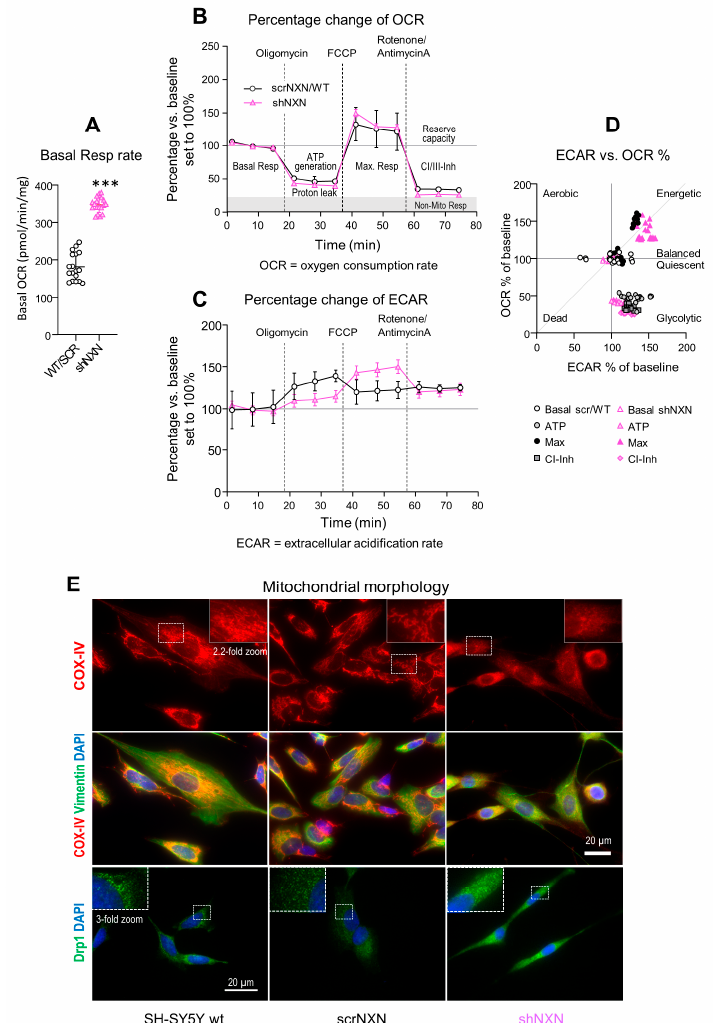
Figure 3. Seahorse analysis of oxidative respiration and extracellular acidification. ( A ) Mitochondrial respiration was analyzed on the Seahorse analyzer. The oxygen consumption rate (OCR) shows the absolute basal respiration (every 3 time points per culture) in shNXN and scrNXN/wildtype SH-SY5Y cells in the presence of full nutrient supplements (pyruvate, glutamine and glucose). Basal respiration differed significantly between groups. Sample size n = 6 cultures per group, *** unpaired, 2-tailed t -test p < 0.001. ( B , C ) Oxygen consumption (A: OCR) and extracellular acidification (B: ECAR) in the “substrate-uncoupler-inhibitor-titration” protocol measured OCR and ECAR upon mitochondrial stressors (Cell Mito Stress Test). After basal respiration (in the presence of pyruvate, glutamine and glutamate), oligomycin was applied to assess ATP generation and proton leakage, subsequently FCCP to assess maximum respiration, and finally rotenone (Complex-I inhibitor) plus antimycin A (Complex-III inhibitor) to assess residual non-mitochondrial respiration. Oxygen consumption (A: OCR) and extracellular acidification (B: ECAR) were normalized according to the protein content, and OCR and ECAR are expressed as percentage change versus basal respiration. Sample sizes were n = 6 per group. scrNXN and wildtype SH-SY5Y were pooled. Time courses were compared by 2-way ANOVA for “group” X “stimulus”. There were no significant differences between groups for OCR, but ECAR showed a significant interaction, p < 0.05. ( D ) The ECAR versus OCR plot shows the energy map and clustering according to the stimulus, but no significant differences between groups. At maximum respiration, control cells split in two clusters, whereas all shNXN cells were highly energetic. ( E ) Morphology of mitochondria in wildtype SH-SY5Y, scrNXN and shNXN cells immunostained with anti-cytochrome oxidase IV (COX-IV) or dynamin-related protein 1 (Drp1). Vimentin shows the cytoskeleton and DAPI the nuclei. The dotted rectangles show the regions which were used for 2.2-fold zoom-ins. shNXN mitochondria display as small-dispersed dots, whereas mitochondria show typical filamentous-net morphology in wildtype and scrambled control